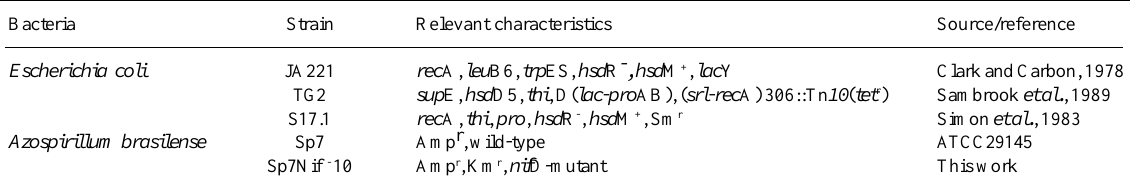
Table I - Bacterial strains used in the present study.